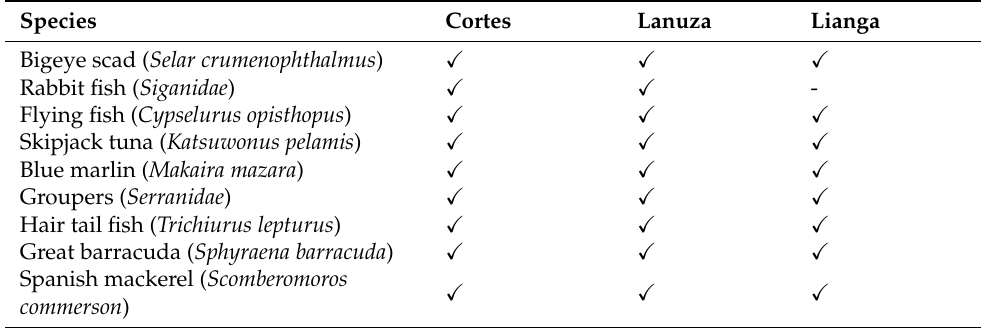
Table 3. Common catch species found in Surigao del Sur. Species